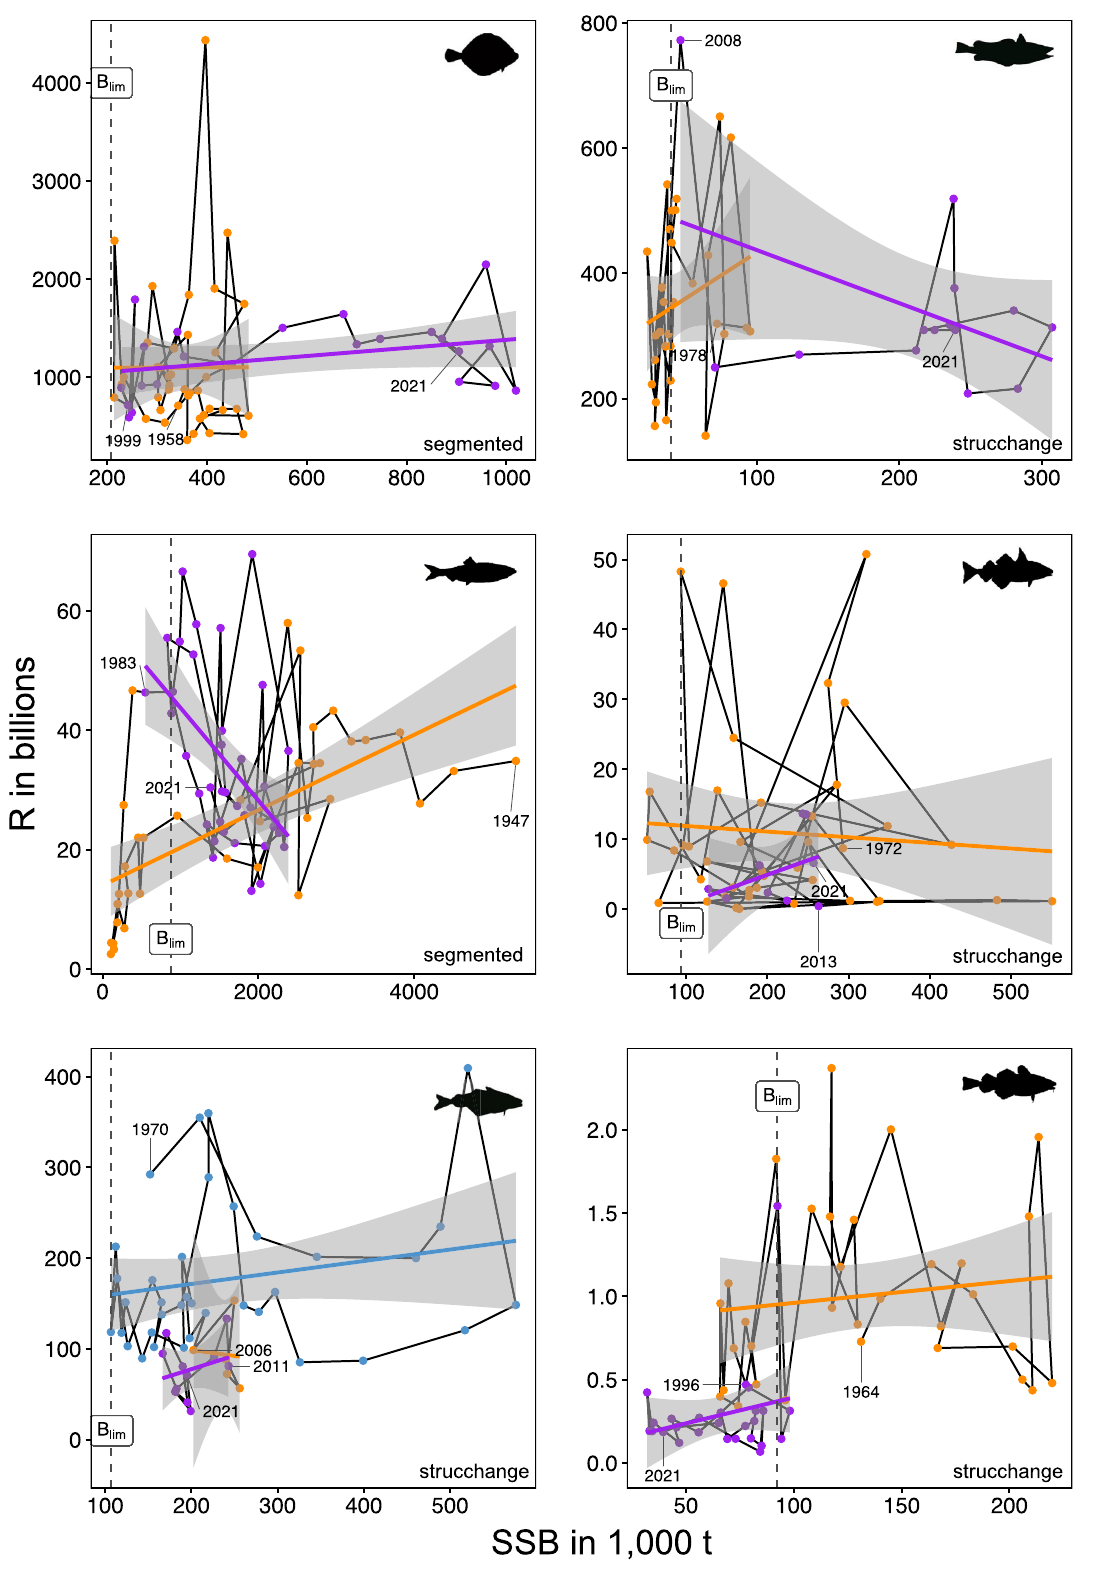
Figure 3. Non-stationary functional relationships in North Sea fish stocks. Break points in non-linear stock- recruitment relationships. Vertical dashed line represents biomass reference level B lim . Colours represent linear models per periods identified by breakpoint